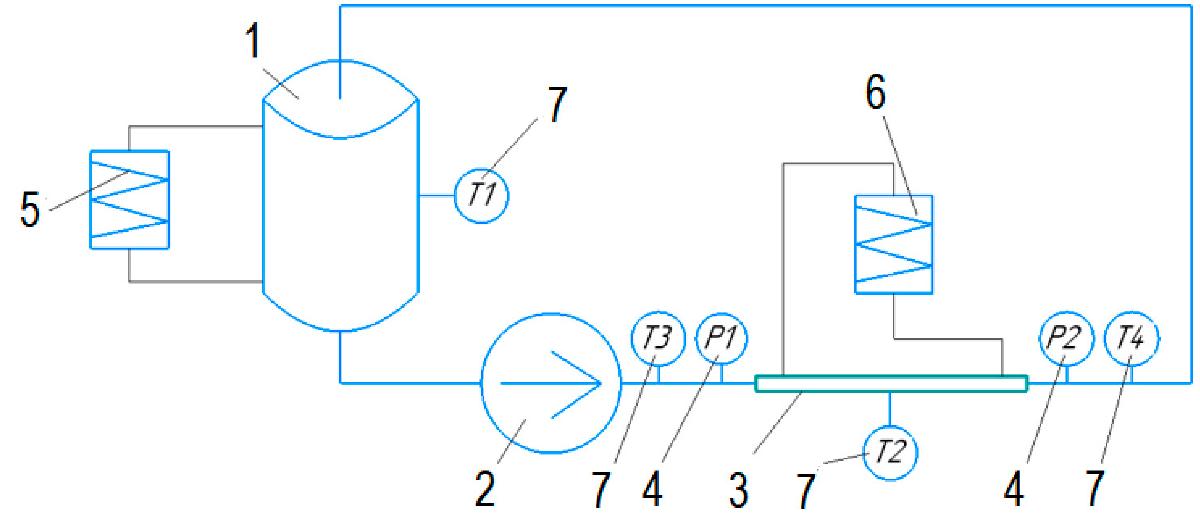
Figure 1. Process flow diagram of flow test high-pressure hydraulic circuit. 1-feedstock tank; 2-a circulation pump; 3-a test section; 4-high-precision pressure sensors at the inlet and outlet of section; 5-specified temperature maintenance systems for pumped flow; 6-inside wall surface of test section; 7-digital thermometers.